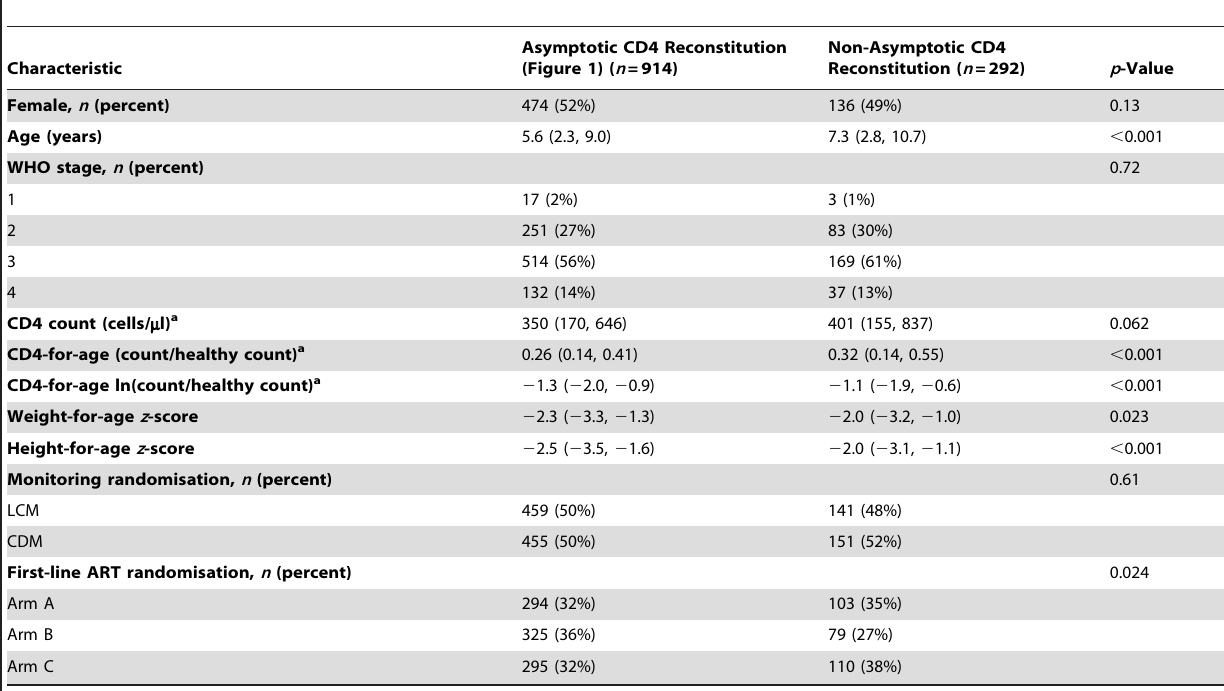
Table 1. Characteristics at ART initiation of the two groups of HIV-infected ART-naı¨ve children in the ARROW trial with qualitatively different CD4 reconstitution profiles.